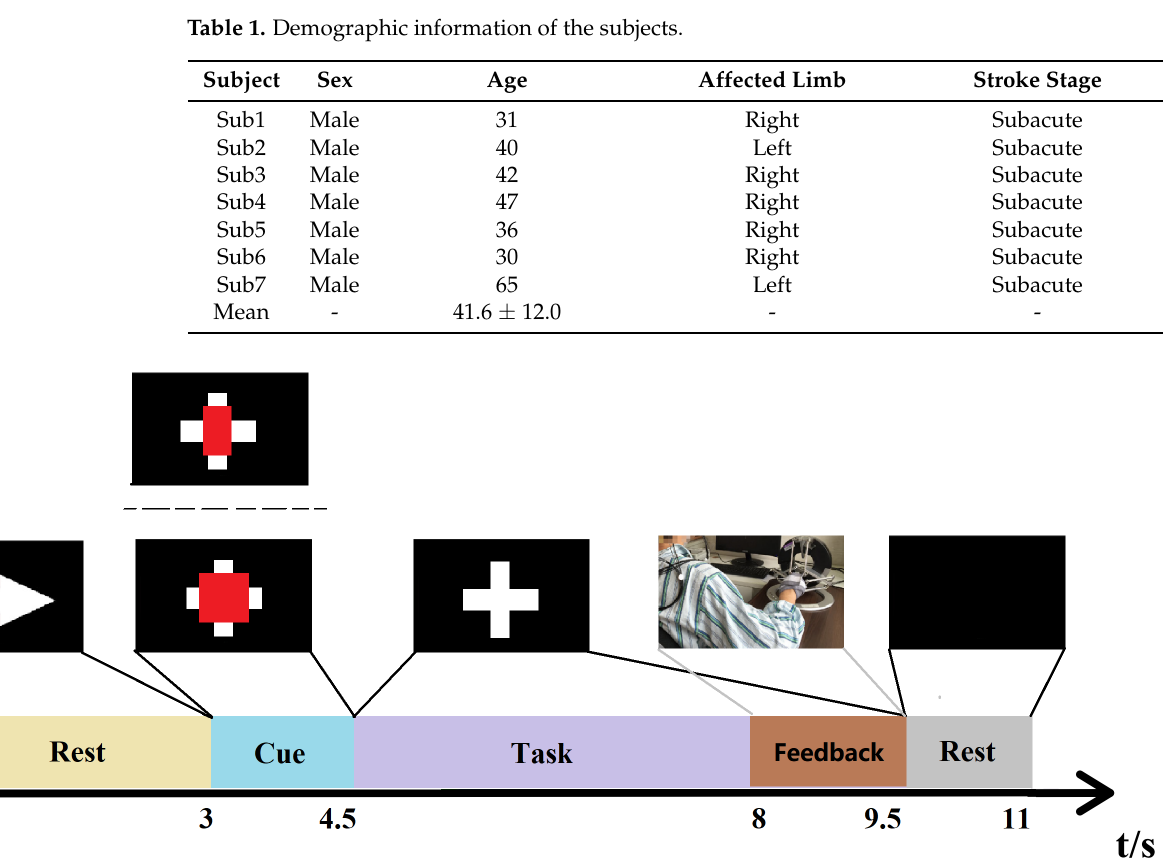
Figure 1. Experimental protocol of rehabilitation training. During the cueing period, a red rectangle is used to alert the user to perform specific tasks. When the cue is a red square, the patient will attempts wrist extension using the stroke-affected hand as hard as possible until the white cross disappears. When the cue is a red rectangle, the patient just needs to stay rested. The patient’s stroke-affected hand was passively extended by the force feedback device when the system accurately identified the patient’s motor